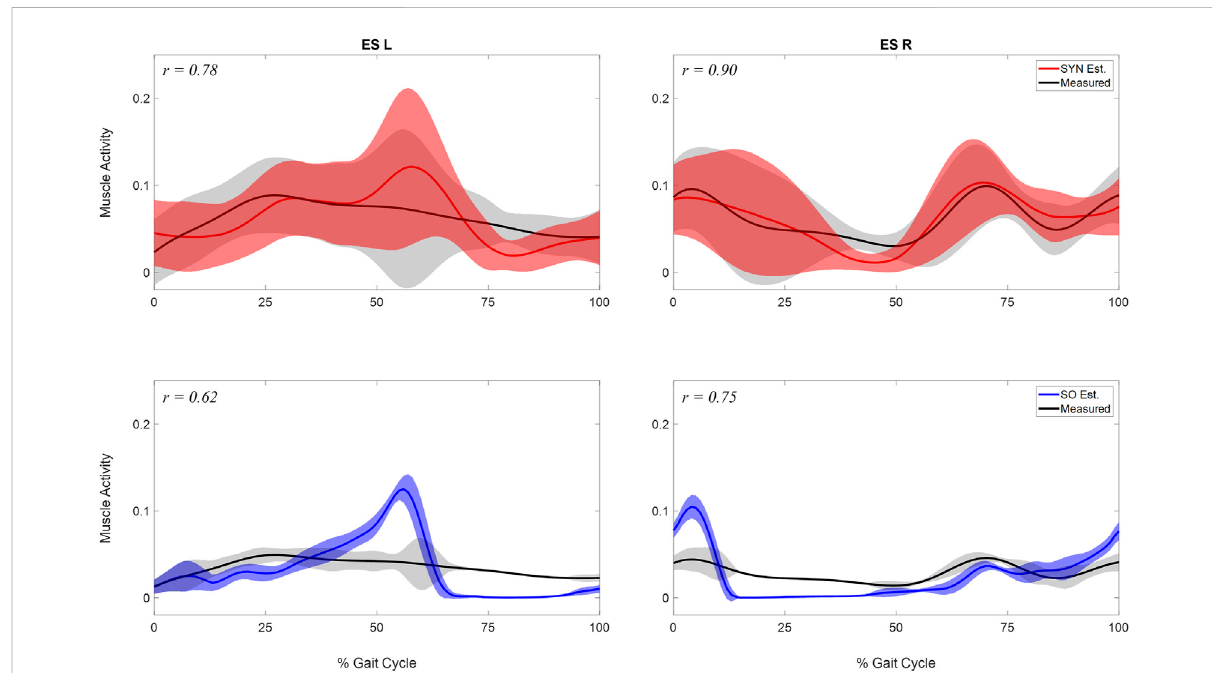
FIGURE 4 Comparisonofestimatedandmeasuredmuscleactivityoferectorspinaeleft(ESL)andright(ESR).Meanandstandarddeviationofmuscleactivations across the 10 analyzed gait cycles were represented by the curve and the shaded area respectively. The activations were estimated by two methods: 1. the synergy-basedmethodproposedinstudy(SYNEst., showninthe fi rst row), using7 synergiesand Allow a (cid:1) 0 . 50; 2. thestaticoptimizationmethod(SO Est., showninthesecondrow).Forthepurposeofdisplayandcomparison,themeanofstandarddeviationofmeasuredmuscleexcitations(representedby the black curve and grey shaded area) were both electromechanically delayed and scaled to minimize the difference with the estimated activations. The correlations between the mean curves of estimated and measured muscle activity were displayed at the top left